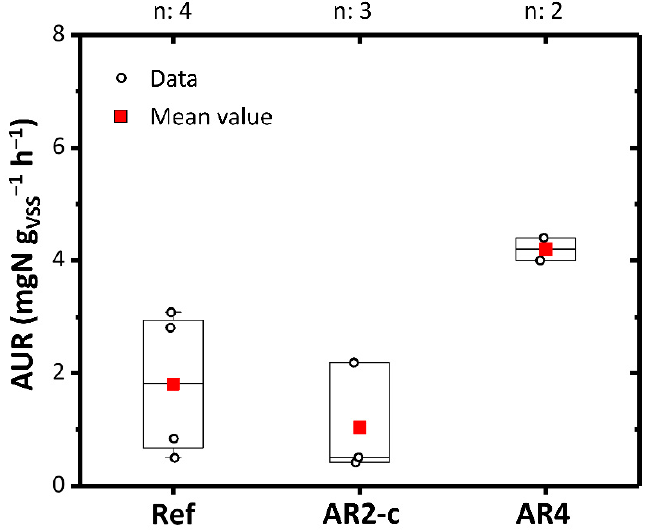
Figure 5. AUR with AR2-c and AR4. Ref: Reference value. Boxplots represent the distance between the first and third quartiles while whiskers are set as the most extreme (lower and upper) data point not exceeding 1.5 times the quartile range from the median. n: number of data points.